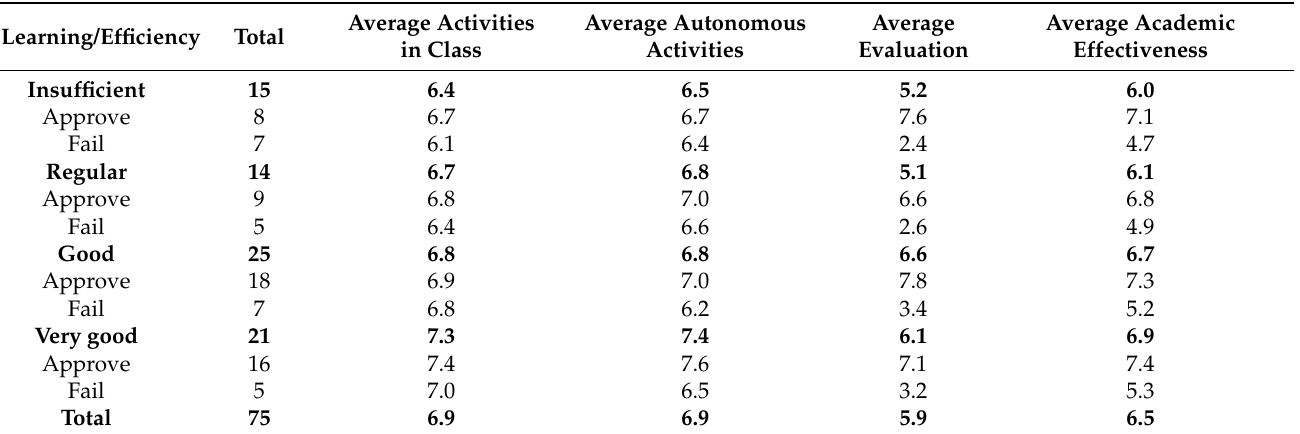
Table 16. Analysis of the data obtained from the 2021 period with the establishment of the categories of learning and academic effectiveness.